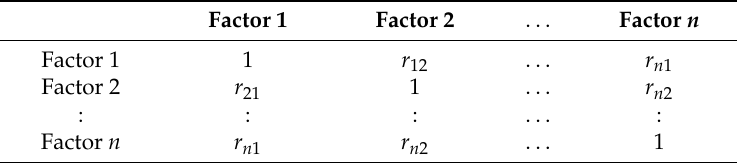
Table 3. The correlation matrix of landslide